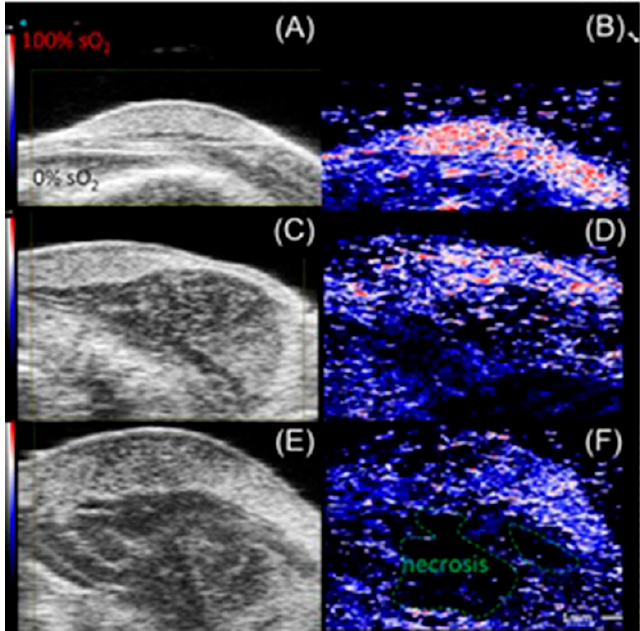
Figure 4. Representative set of anatomic images of a tumor recorded in B-mode and oxy-hemo mode ( A , C , E ). Different tissues (brighter shade and darker areas) correspond to photoacoustic panels ( B , D , F ) of small, medium, and large tumors and depict vital areas (brighter pixels in a B-mode and oxygenated areas in photoacoustic oxy-hemo mode are blue and red, respectively) and less oxygenated and necrotic areas inside tumors. Scale bar represents 1 mm. Adapted from Ultrasound in Medicine and Biology , 47 , Keša, P.; Pokorná, E.; Grajciarová, M.; Tonar, Z.; Vo č ková, P.; Trochet, P.; Kope č ek, M.; Jakša, R.; Šefc, L.; Klener, P. Quantitative in vivo monitoring of hypoxia and vascularization of patient-derived murine xenografts of mantle cell lymphoma using photoacoustic and ultrasound imaging, 1099–1107, Copyright 2021, with permission from Elsevier [248].